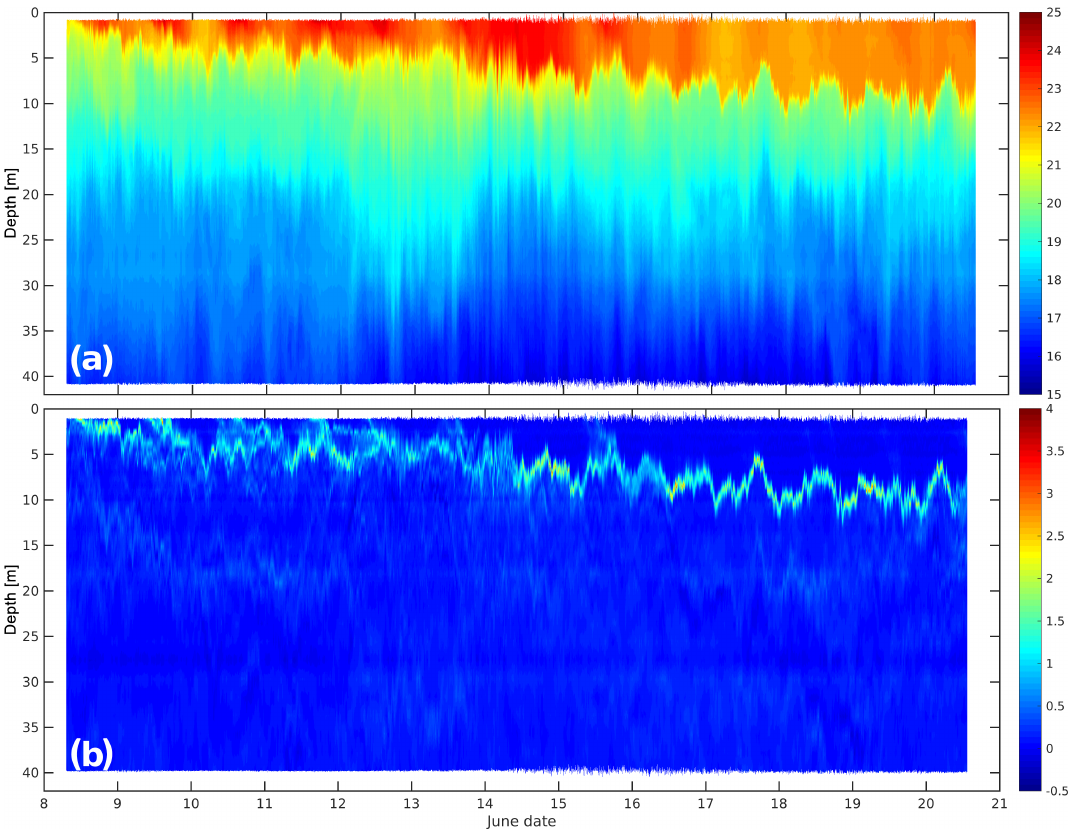
Figure 2. (a) The observed temperature [ ◦ C] at mooring M1 and (b) the vertical temperature gradient [ ◦ Cm − 1